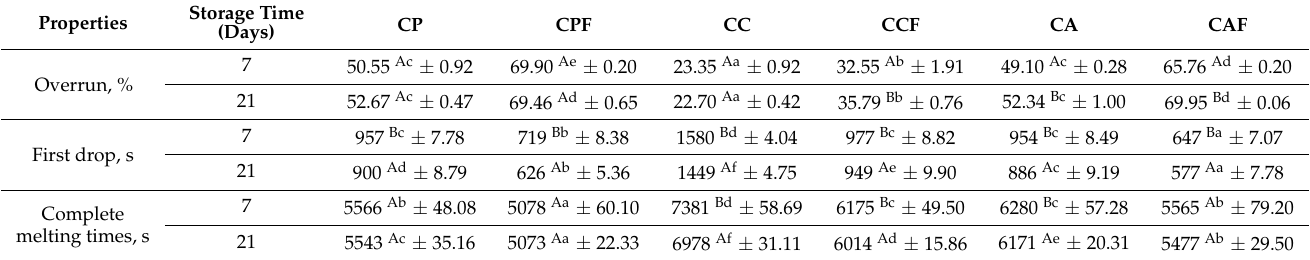
Table 5. Overrun, first dropping time, and total melting rate of ice cream in 7 and 21 days of